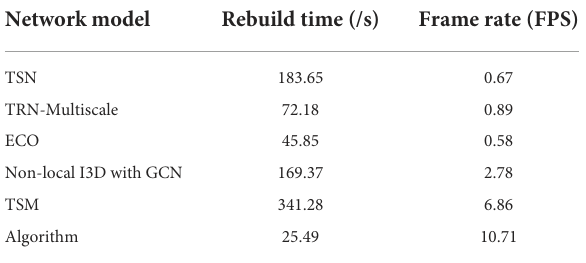
TABLE 7 Comparison of reconstruction time of different algorithms.